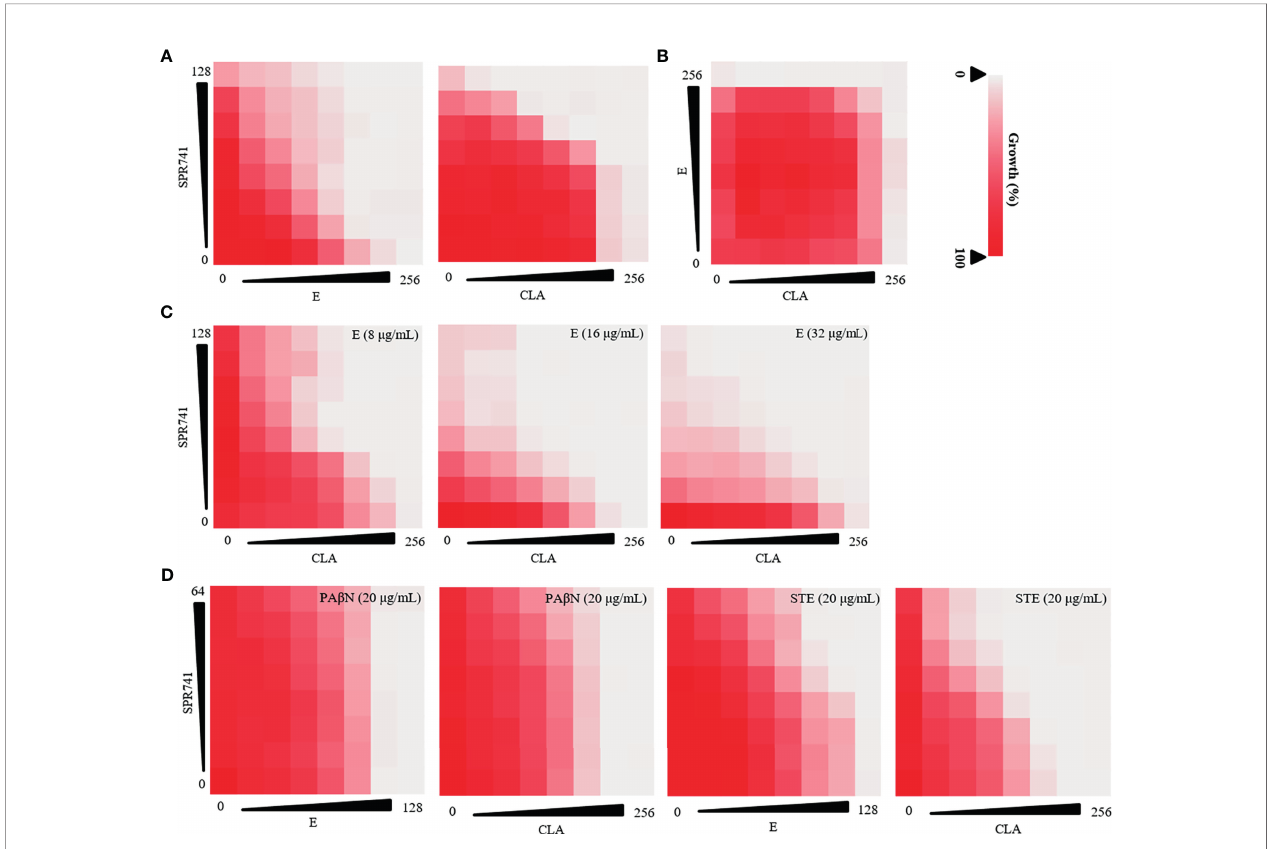
FIGURE 1 | Anti-bacterial effect of double or triple combination against PDR K. pneumoniae LH2020 was determined using checkerboard assay. Double antibiotic combination of SPR741 with CLA or E (A) and CLA combined with E (B) against K. pneumoniae LH2020. (C) Triple antibiotic combination of SPR741 with CLA and various concentrations of E. (D) Triple drug combination based on SPR741, CLA/E combined with 20 µg/mL ef fl ux pump inhibitor PA b N/STE. Experiment was repeated three times.